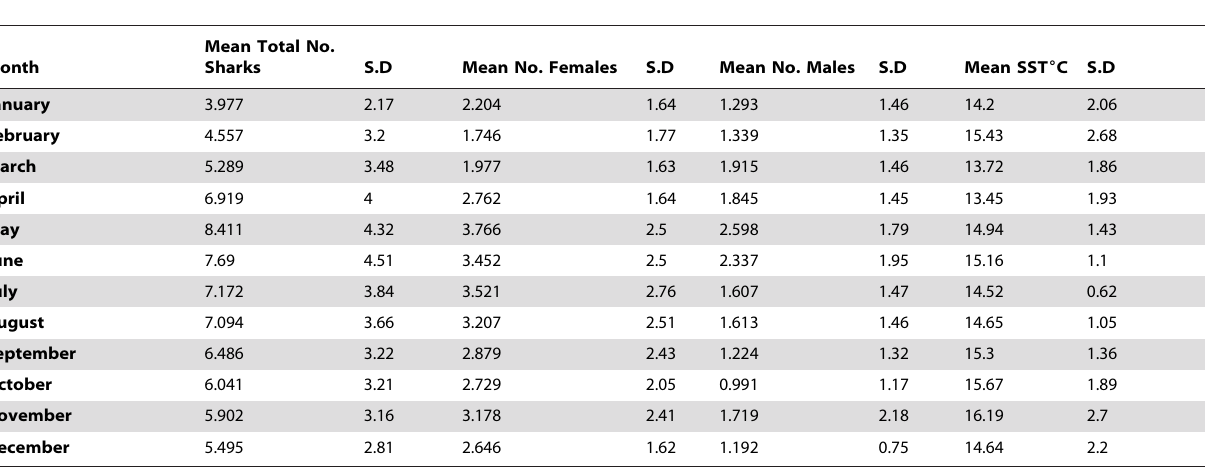
Table 2. Mean numbers of white sharks sighted per month (total, female and male) with mean monthly sea surface temperatures in Gansbaai, 2007 to